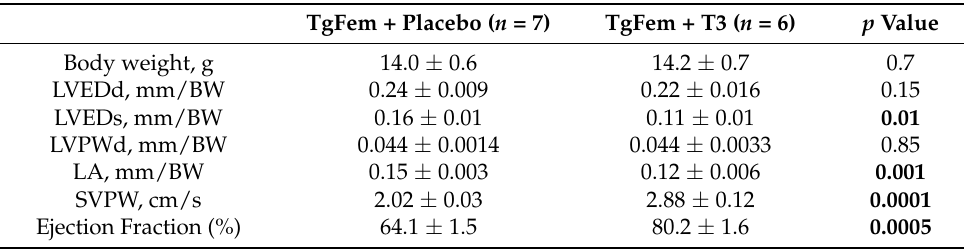
Table 2. Echocardiographic analysis in female Tg197 mice receiving either placebo or T3 for 10 days from 10th to 11th week.